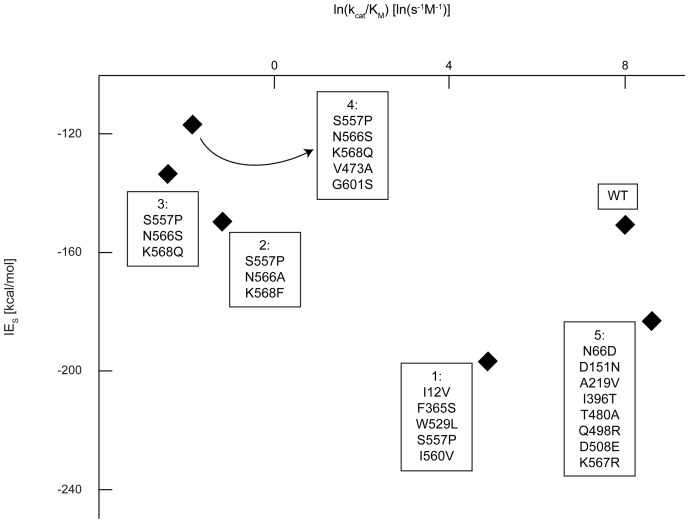
pNP-GLU IES correlation with catalytic efficiency.Data was obtained as described for Figure 5. No significant correlation is observed (R2 = 0.545) between IE with pNP-GLU and ln(kcat/KM). If GUS catalysis was primarily achieved through reactant destabilization, a positive slope would have been expected.